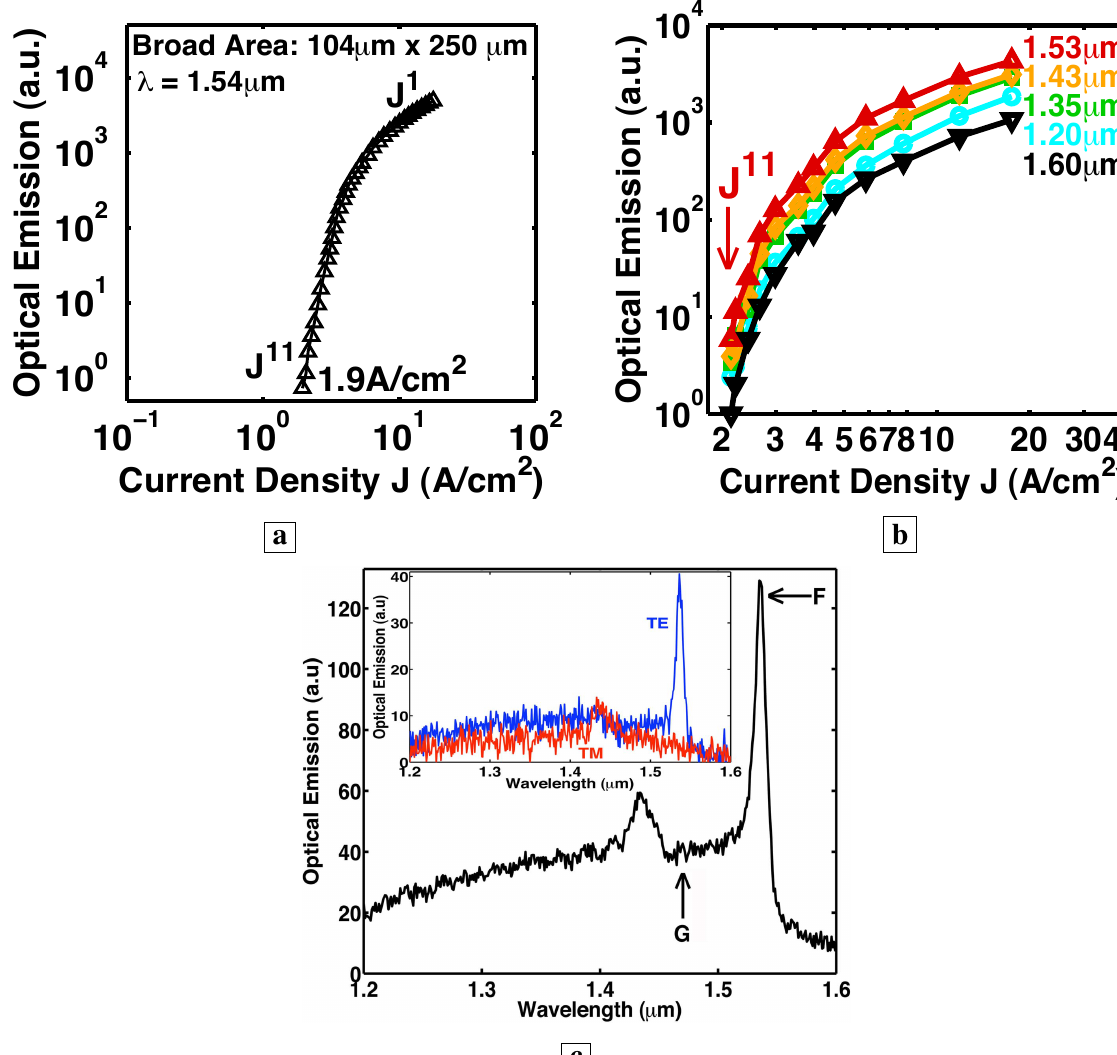
Figure 17 . Room-temperature measurements [5] in cw-mode from a resonant cavity (bottom DBR and RIE facets). a, The stimulated-emission at 1.54 µ m from Sample L is seen to rise a significant three orders of magnitude as J 11 , beyond which the optical-emission quickly becomes linear in J. The latter indicates gain pinning and laser action. b, The constant vertical separation on a log-log plot of the L-I curves at different wavelengths from the same pixel indicates that the optical-emission has the same spectral shape for all indicated J, and that the carrier distribution is pinned among the energy-levels. (Without the resonant cavity, the optical emission shows a significant shift in the population distribution with increasing injection.) c, Optical-emission spectra from Sample L at 17 A/cm 2 . All samples having a resonant cavity showed that the low-loss TIR mode, labeled G in Figure 17c, is suppressed, while the lossy vertical mode, labeled F in Figure 17c, dominates the spectra as a narrow peak. The latter signifies that enough material gain exists to overcome the large 70% transmission loss incurred by the vertical mode with each trip to the sample